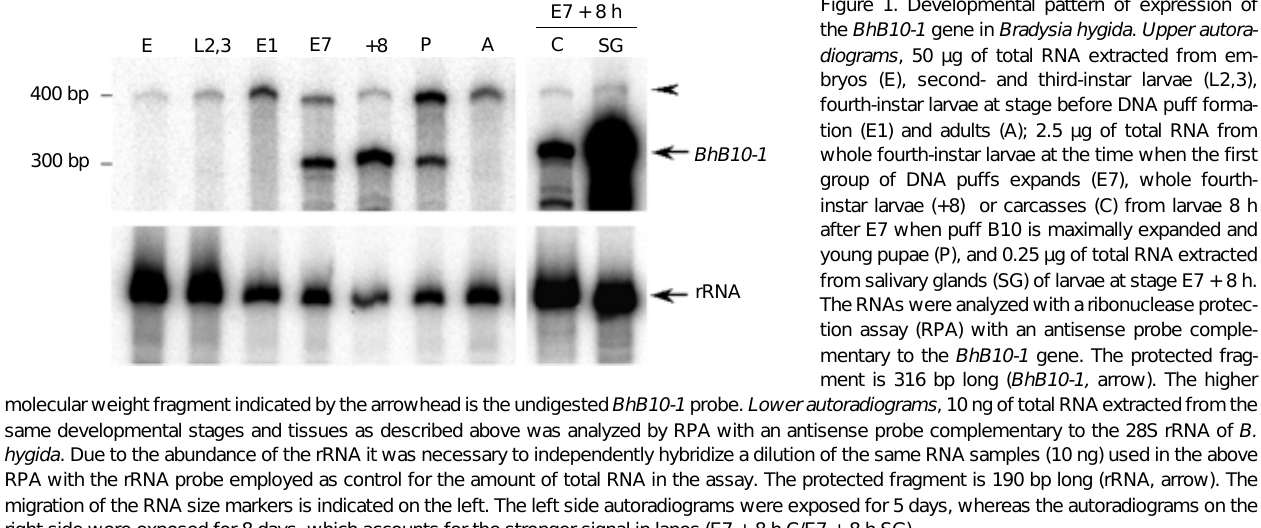
Figure 2. Northern blot characterization of BhB10-1 mRNA expression in different tissues at the end of the fourth larval instar of Bradysia hygida . Upper autoradiogram , Northern blot after hybridization with the 2-kb genomic fragment from DNA puff B10, which contains the BhB10-1 transcription unit (5). The lanes contain about 7 µg of total RNA extracted from brain (B), gut (G), Malpighian tubules (M), fat body (F) and integument (I) of larvae at a stage be- fore puff formation (lanes E1) and larvae at the stage when puff B10 is maximally expanded (lanes E7 + 8 h), about 7 µg of total RNA extracted from salivary glands (SG) of larvae at E1, and 0.5 µg and 1.0 µg of total RNA extracted from salivary glands of larvae at E7 + 8 h (lanes SG). The arrow points to the BhB10-1 mRNAs ranging from 1.3 to 1.1 kb. The extra bands of higher molecular weight are not reproducible. The lower picture is an image of the gel before blotting to show the loading of the lanes. The migration of the 28 and 18S mammalian ribosomal RNA, employed as molecular size markers, is indicated by asterisks on the